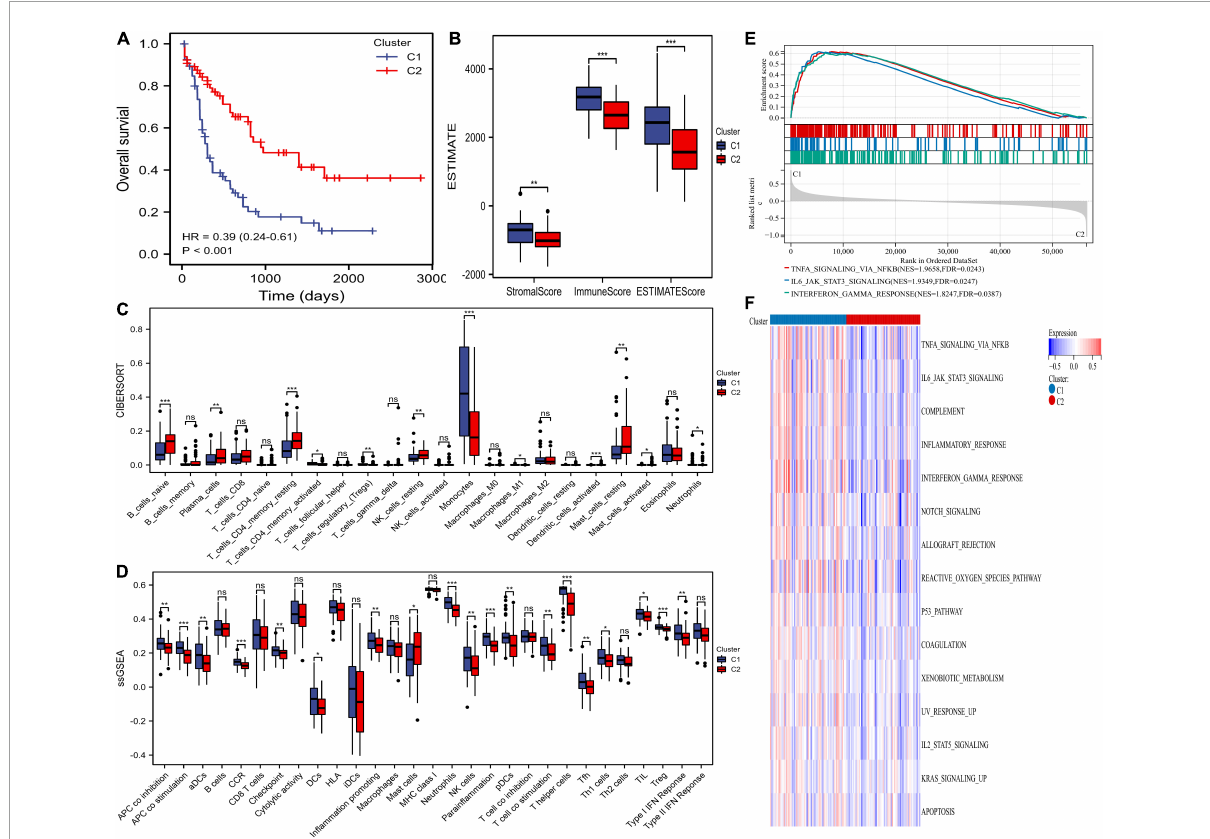
FIGURE2 Differences in prognosis, immunity, and pathway enrichment between the two clusters. (A) overall survival (OS) of the two clusters. (B) The ESTIMATE algorithm calculated stromal, immune, and ESTIMATE scores between the two clusters. (C,D) The differences in immune cells and immune responses between the two clusters by the CIBERSORT and single-sample gene set enrichment analysis (ssGSEA) algorithms. (E,F) Heatmaps of hallmark analysis in the two clusters by gene set enrichment analysis (GSEA) and gene set variation analysis (GSVA) enrichment analyses. * p < 0.05, ** p < 0.01, *** p < 0.001, ns, no